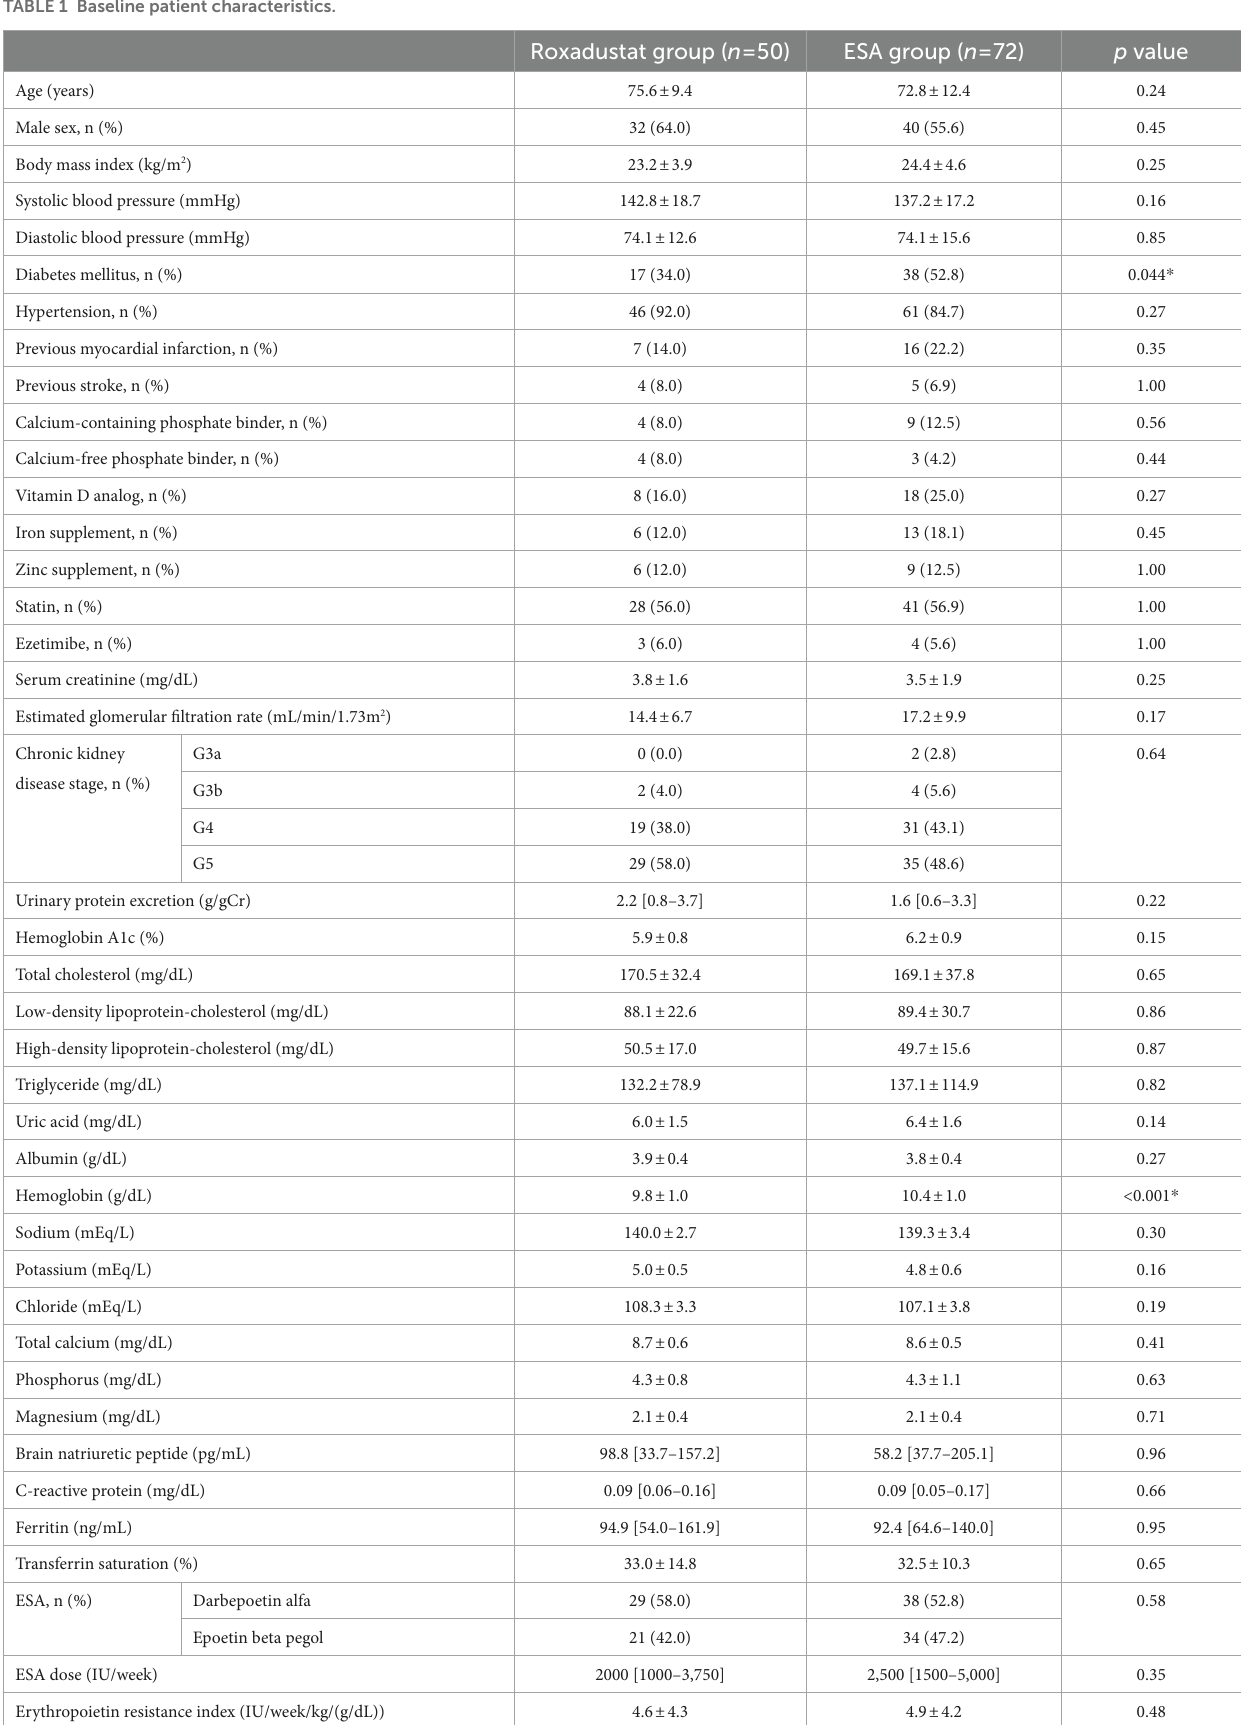
TABLE 1 Baseline patient